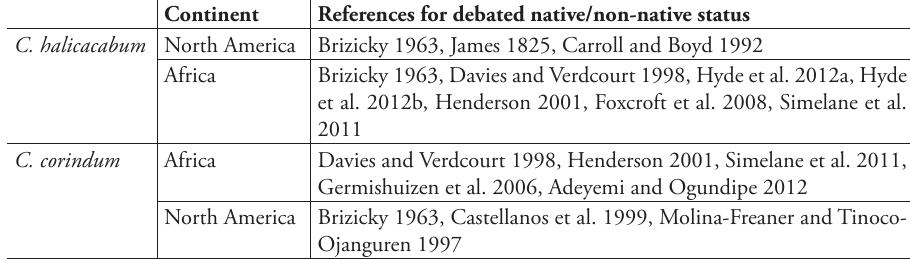
Table 1. Details of uncertain native or non-native statuses of two Cardiospermum species in North Amer- ica and